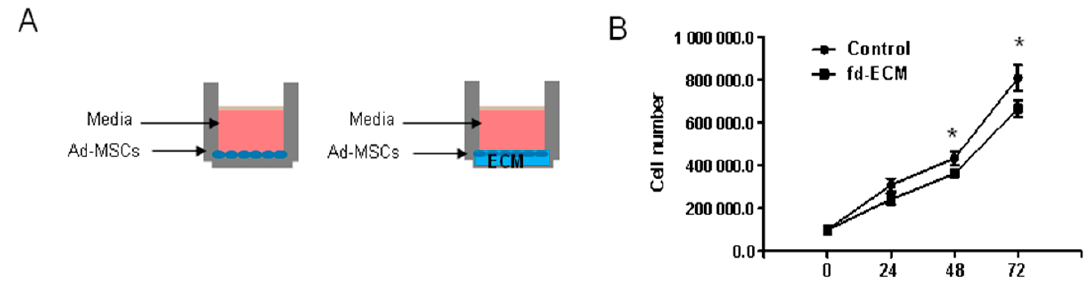
Figure 4. Cont. Figure 4. Cont.